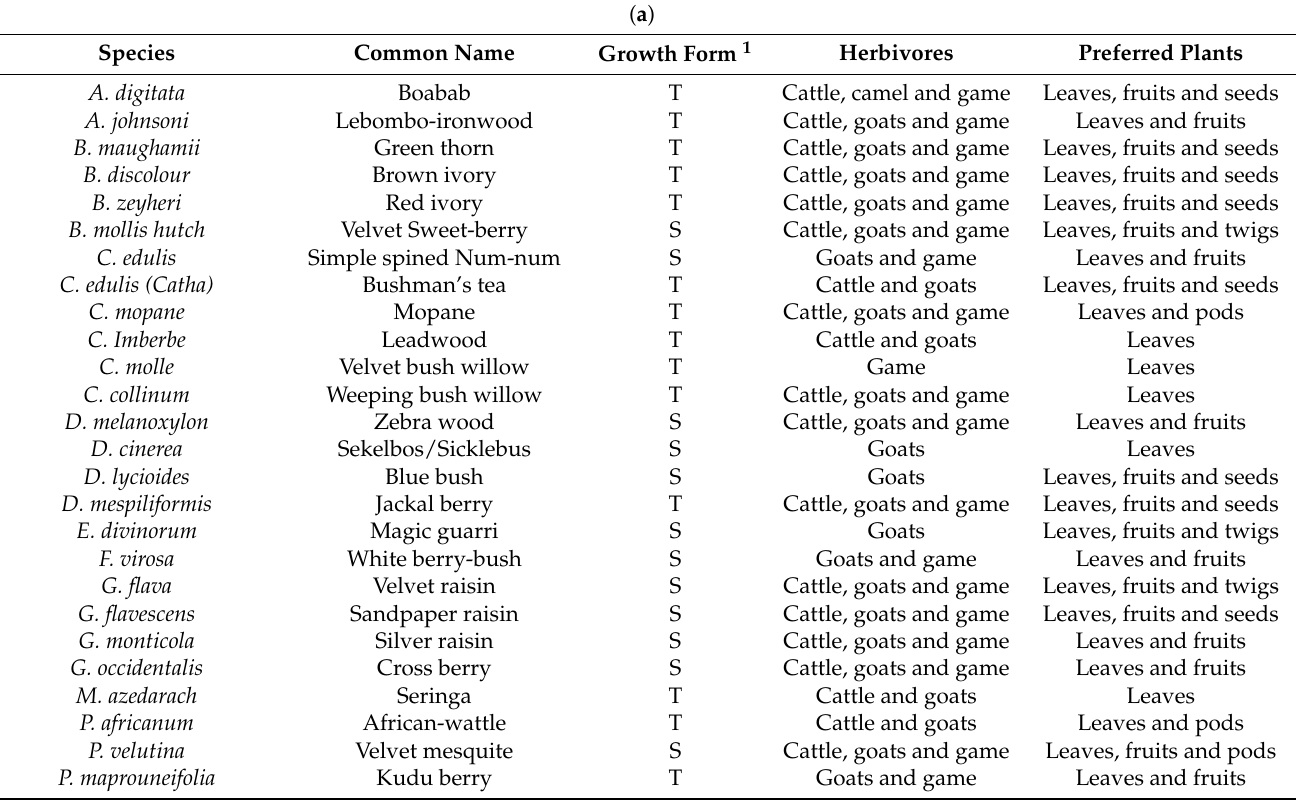
Table 9. Scientific and common names, growth form, herbivory and preferred plants of woody browse species located in semi-arid areas of two different provinces (Limpopo and North West) of South